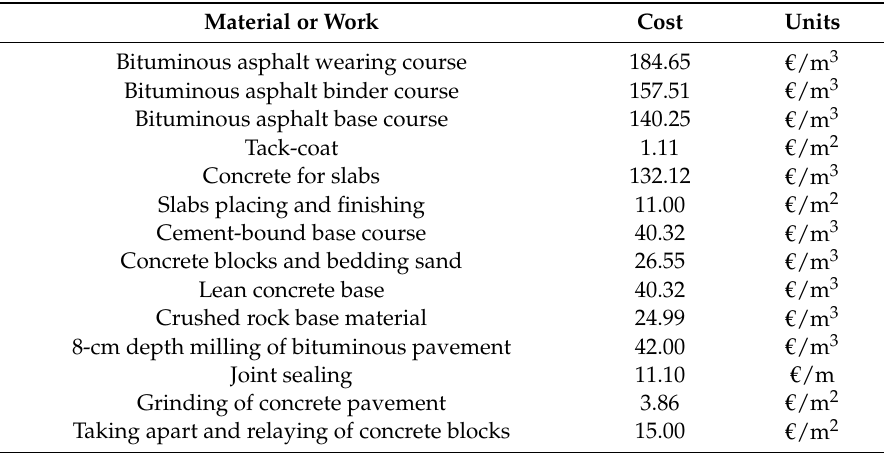
Table 13. Unit prices of construction and maintenance costs.